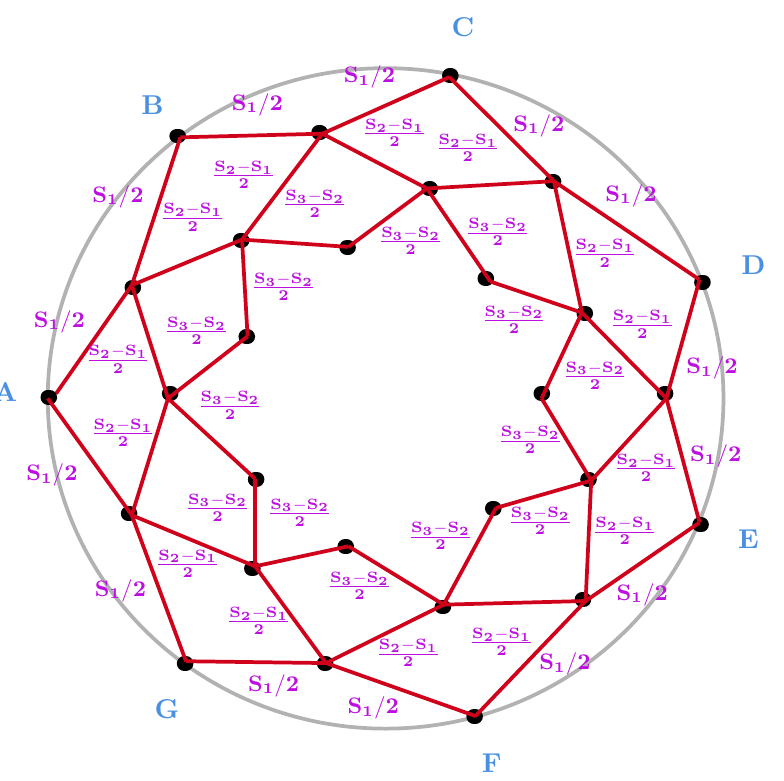
Figure 14 . The 7 -region diamondwork graph in the symmetric case where all one-party atomic regions have entropy S , all two-party regions have contiguous regions have entropy S 1